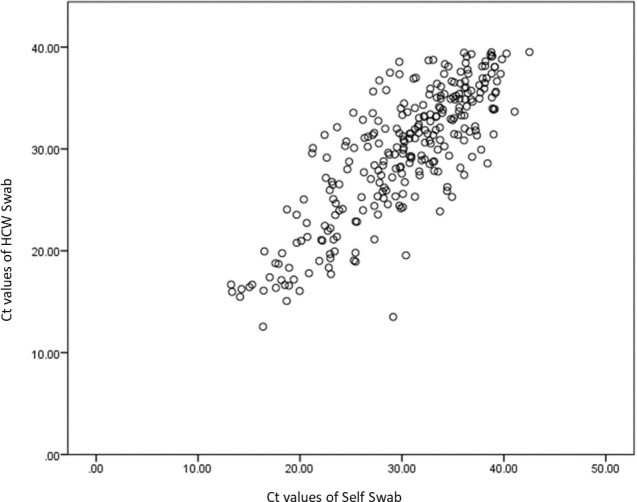
Correlation of Ct values of HCW swab and self-swab.